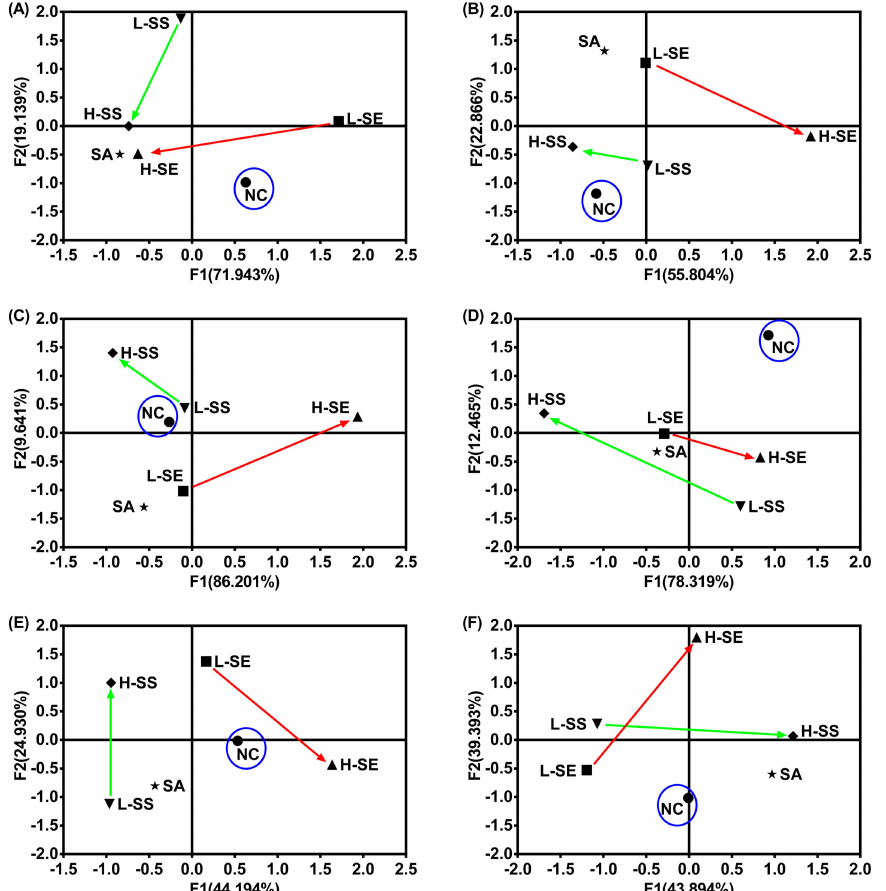
Figure 7. PCA results using the multiple Aqps expressions in organs collected from the normal rats and diarrhea-rats induced by the low dose of senna extract (L-SE), high dose of senna extract (L-SE), low dose of sennoside (L-SS), high dose of sennoside (H-SS), and one dose of sennoside A (SA) for over six days. ( A ) PCA results in the colons; ( B ) PCA results in the kidneys; ( C ) PCA results in the livers; ( D ) PCA results in the spleens; ( E ) PCA results in the stomachs; ( F ) PCA results in the lungs. The green arrow represents the trend from the L-SS to H-SS. The red arrow represents the trend from the L-SE to H-SE. The blue circle refers to the NC